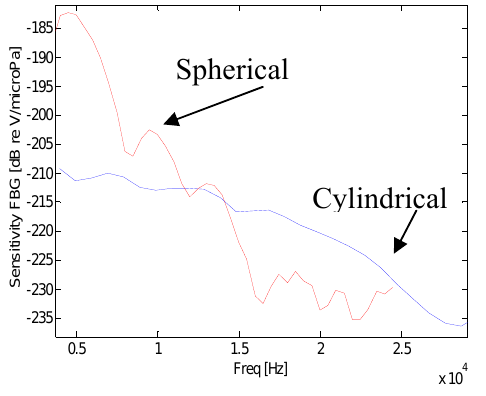
Figure 3. The calculated sensitivity curves of the FBG